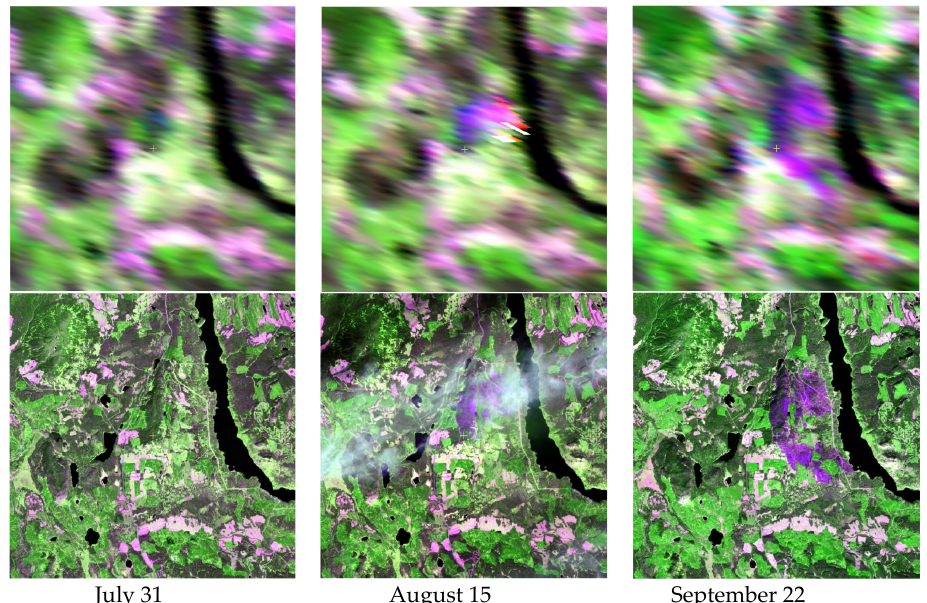
Figure 5. The Torkelsen Lake Fire study site: SWIR1-NIR-SWIR2 (R-G-B) false color composites of MODIS BRDF adjusted surface reflectance (upper row) and Sentinel-2 MSI L2A surface reflectance (lower row) images acquired on July 31, August 15 and September 22, 2018. The dark purple in the upper center of the two images on August 15 and September 22, 2018 shows the burned area. The image on August 15, 2018 also shows some smoke feathers.